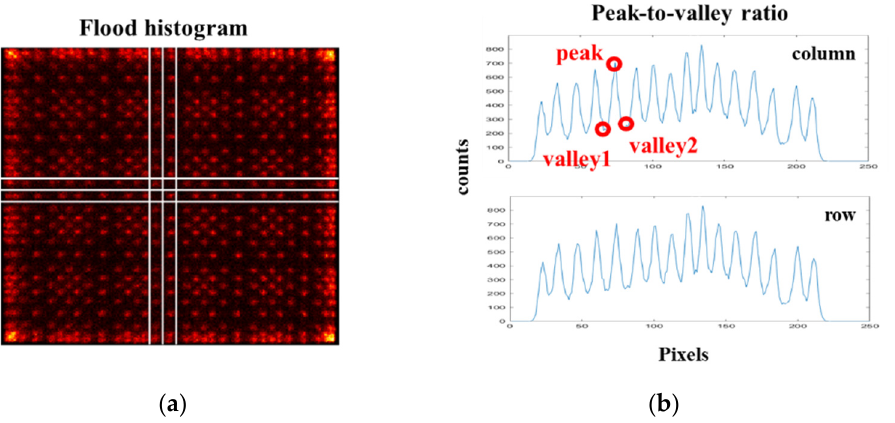
Figure 3. An illustration of the peak-to-valley ratio calculations. ( a ) A typical flood histogram. ( b ) An illustration of the calculation. The profiles of the central column and row of the spots in both the top layer and bottom layer crystals were selected for calculation of the peak-to-valley ratios.